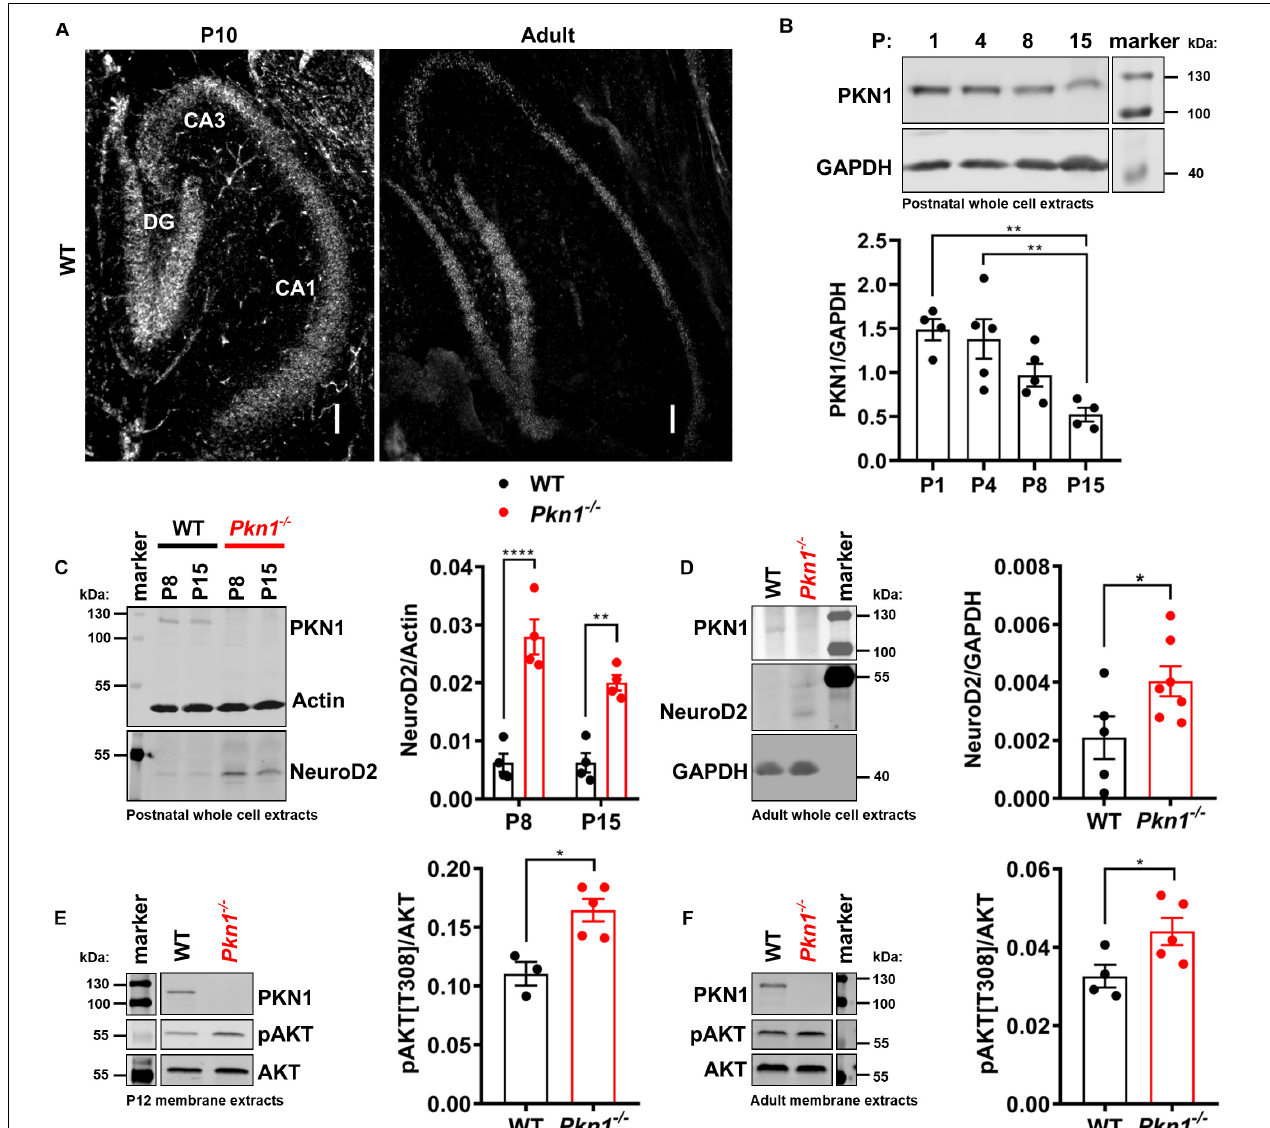
FIGURE 1 | PKN1 regulates AKT phosphorylation and NeuroD2 levels in postnatal and adult hippocampi. (A) P10 and adult hippocampal sections from WT animals were tested for PKN1 expression by in situ hybridization. Pictures are representative of 2–3 separate WT animals. Scale bar refers to 100 µ m. (B) PKN1 expression levels from P1 to P15 old WT hippocampi were assessed by western blotting (** P < 0.01, one way ANOVA with Tukey’s multiple comparisons test). (C) NeuroD2 expression in hippocampal whole cell protein extracts of P8 and P15 old WT and Pkn1 − / − animals was assessed by western blotting (two way ANOVA: Interaction: P = 0.0745, Age: P = 0.0747, Genotype: P < 0.0001, Sidak’s multiple comparisons test: P8: P < 0.0001, P15: P = 0.0025). (D) NeuroD2 expression in adult WT and Pkn1 − / − hippocampal whole cells extracts (* P = 0.0496, unpaired t -test). (E) Hippocampi from P12 old WT and Pkn1 − / − animals were separated into cytosolic and membrane fractions. Membrane extracts were probed for phosphorylated AKT[T308] (pAKT[T308]) and total AKT and the ratio was calculated (* P = 0.0104, unpaired t -test). (F) Membrane fractions of adult WT and Pkn1 − / − animals were probed for pAKT[T308] and AKT (* P = 0.045, unpaired t -test). The markers in